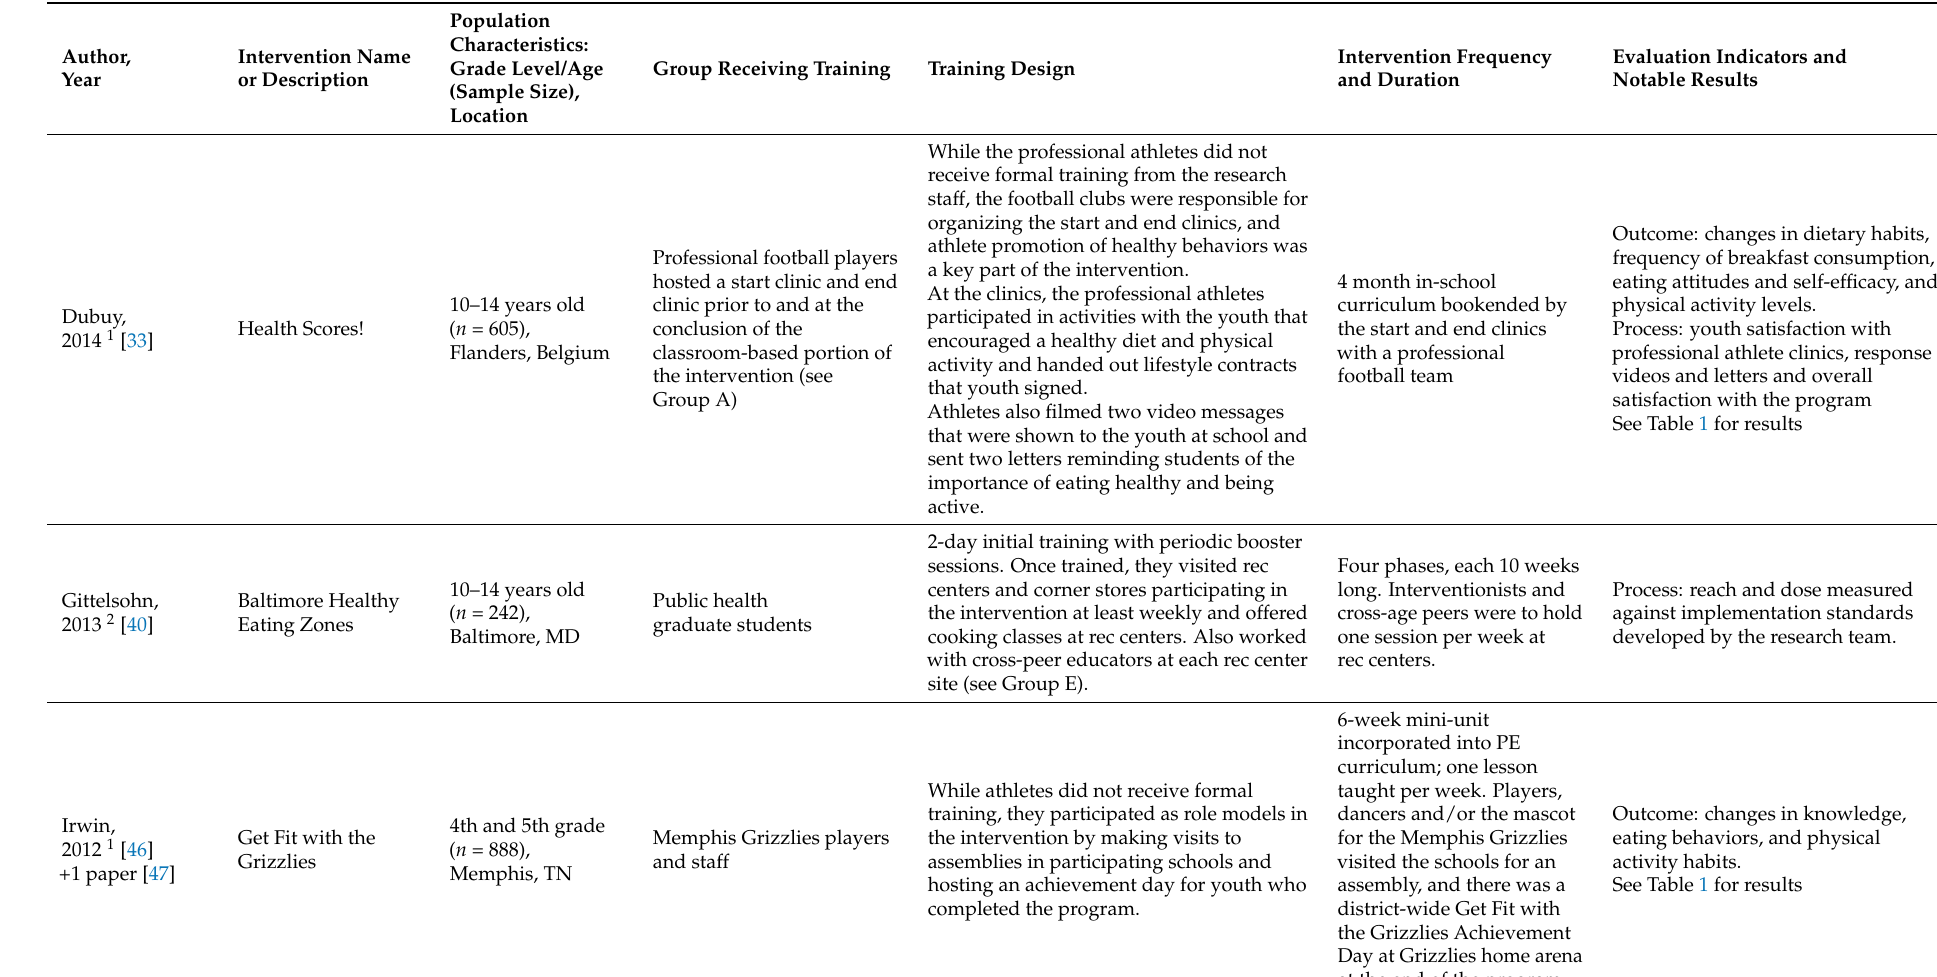
Table 5. Group D: Community, afterschool, or extracurricular interventions that trained